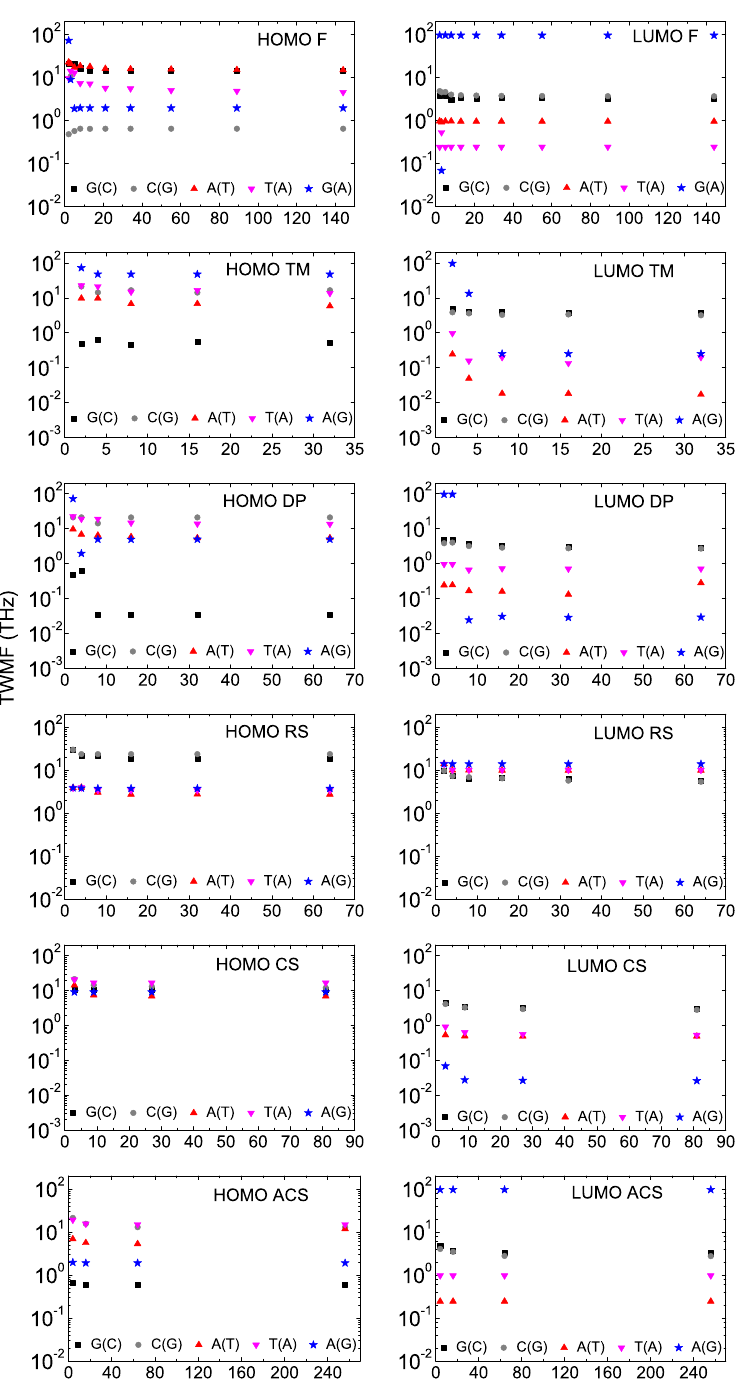
Figure 9. Total Weighted Mean Frequency (TWMF) as a function of the number of monomers N in the polymer, having placed the carrier initially at the first monomer, for Fibonacci, Double Period, Rudin–Shapiro, Cantor Set, Asymmetric Cantor Set polymers, for the HOMO (left column) regime and the LUMO (right column) regime. D Polymers, i.e., made of different monomers, are denoted by blue stars. The notation of polymers is given in Table